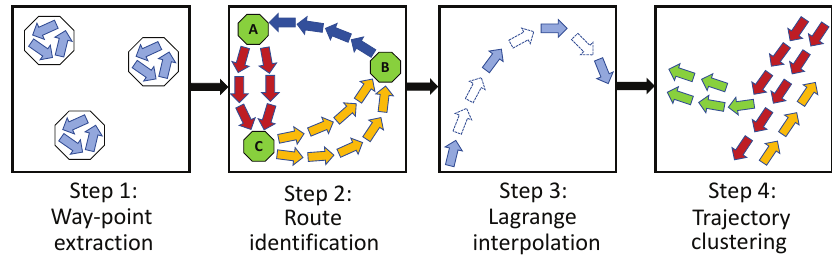
Figure 1. Preprocessing steps for extracting Maritime traffic routes.